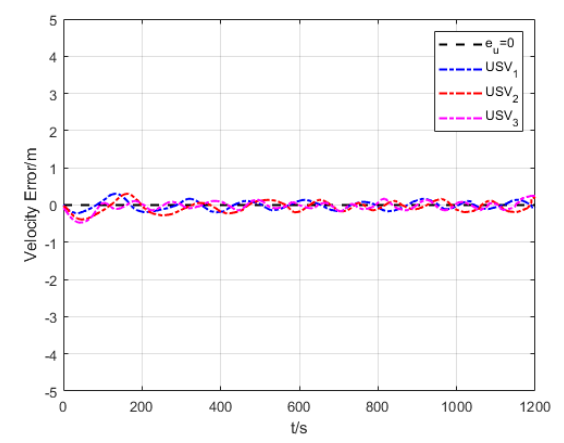
Figure 35. Variation of heading angle error.